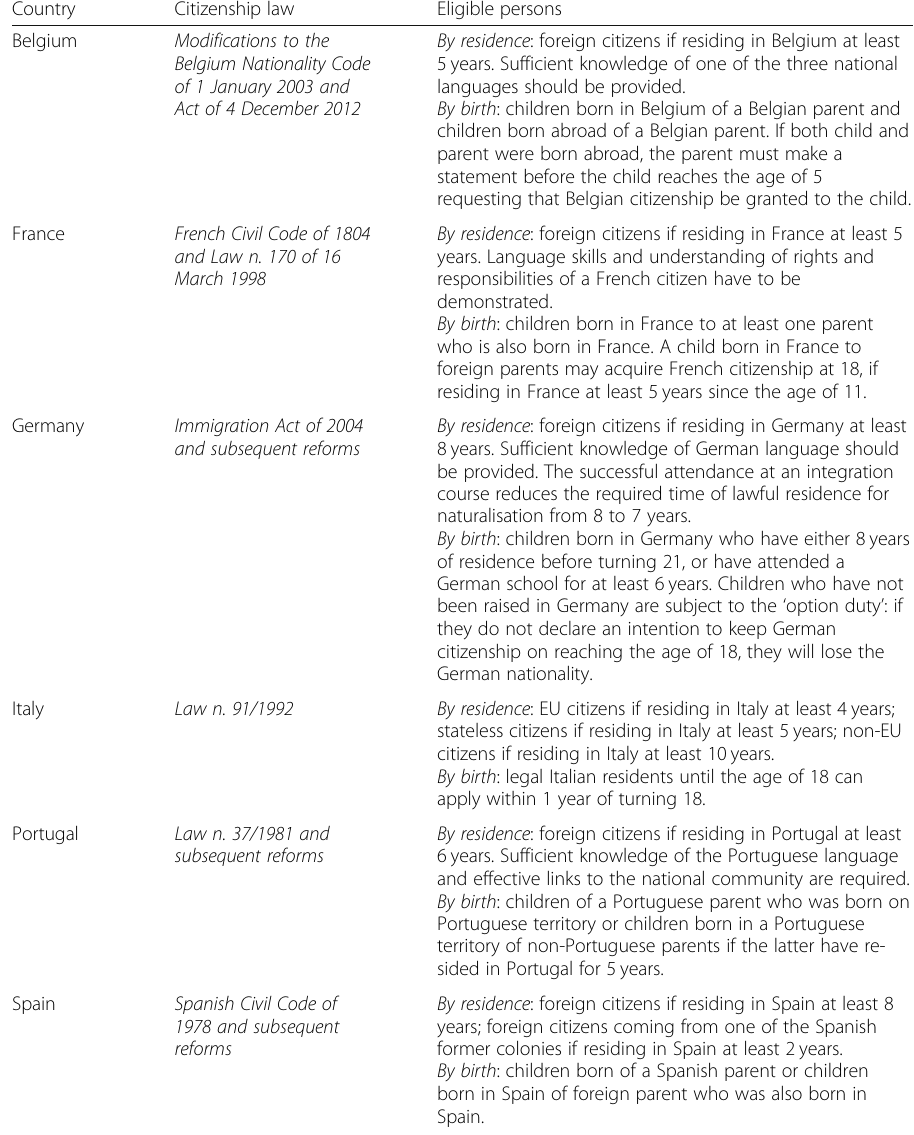
Table 1 Current citizenship regime in the six selected countries